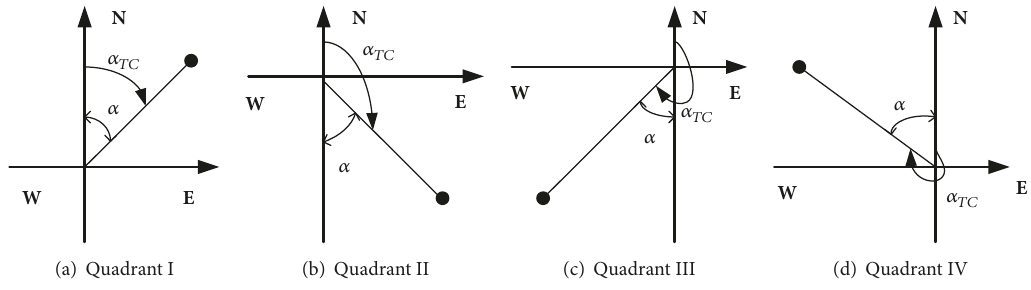
Figure 1: Relationship between 𝛼 𝑇𝐶 and 𝛼